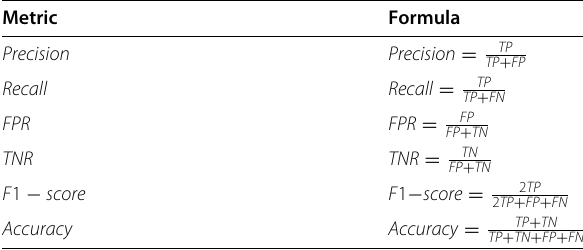
Table 2 The calculation formula for the evaluation metric of the binary classification